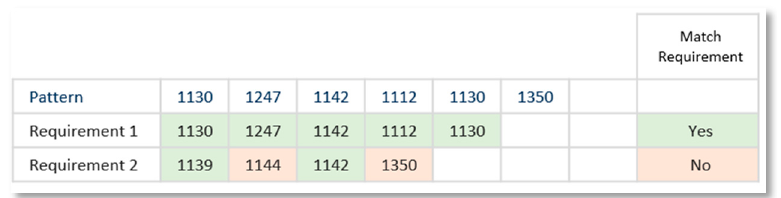
Figure 4. Matching process of a Pattern against several Requirements.